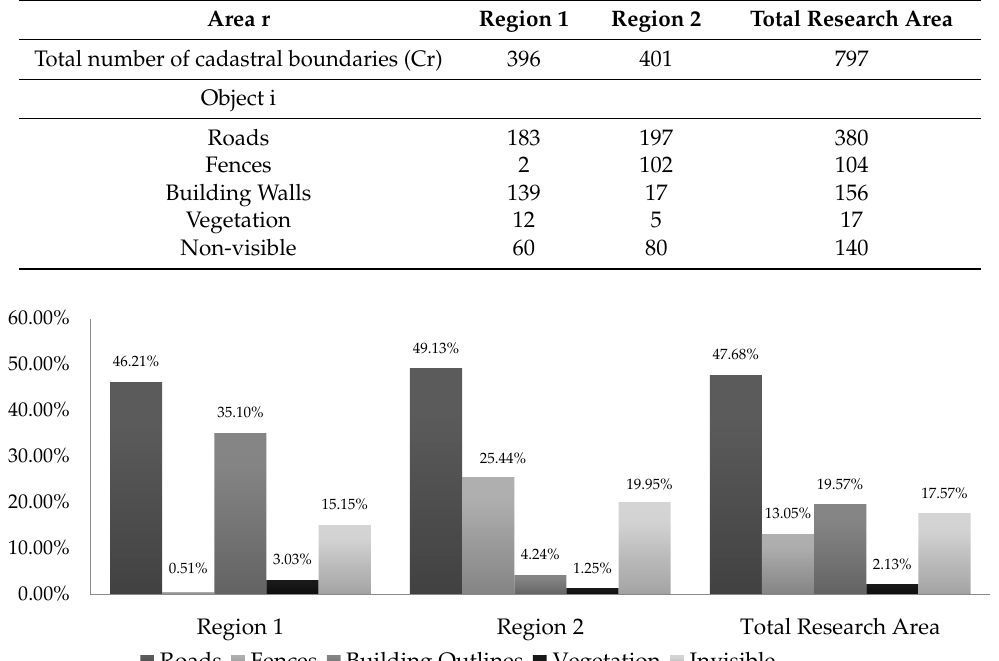
Table 1. The number of cadastral boundaries coinciding with physical objects.